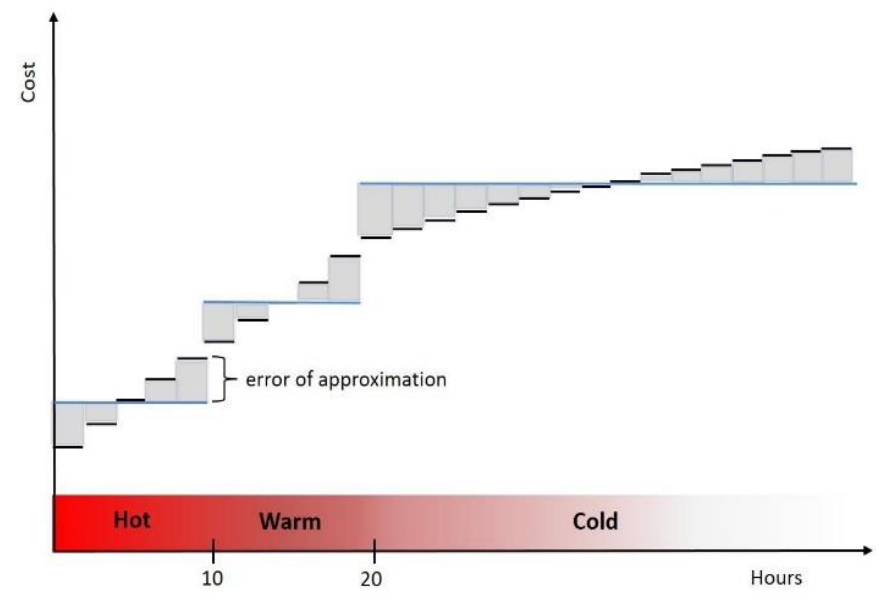
Figure 3. Three-step approximation of the start-up costs. Table 2. Correlation coe ffi cient for JWCD in